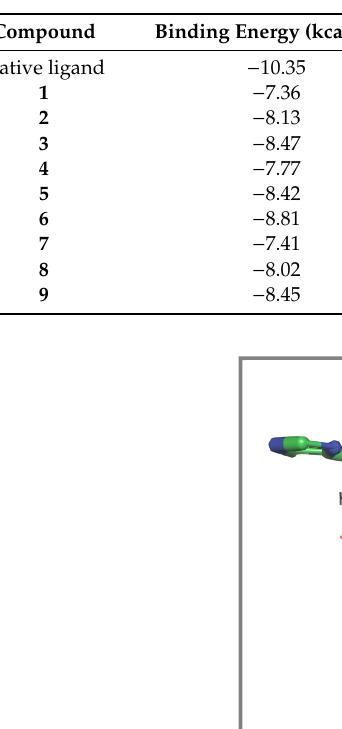
Figure 3. ( a ) protein tyrosine phosphatase 1B PTP1B (1XBO) amino acid residues around the original ligand; ( b ) the native ligand structure. The colors represent the element or atom (Red: Oxygen; Blue: Nitrogen; Yellow: Sulphur; Orange: Phosphor; Green: Carbon of the receptor residues; Cyan: Carbon of ligand; Dotted Yellow line: Interaction between the atoms). Compound Table 3. Binding energies calculated for the compounds by using Autodock 4.2.